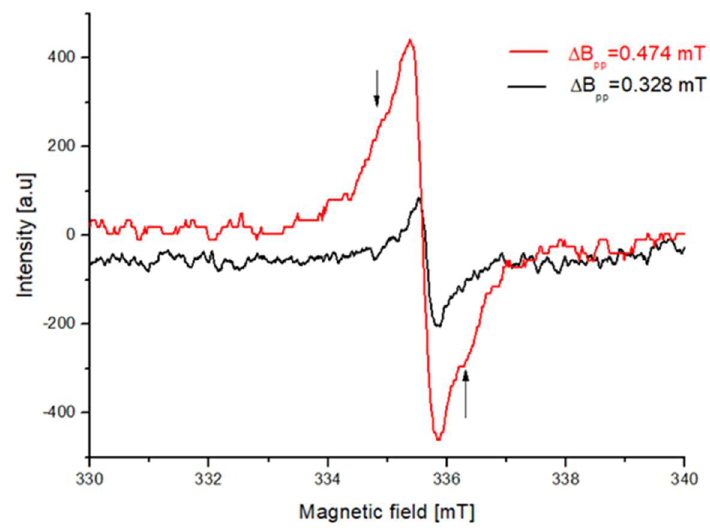
Figure 2. Typical EPR spectrum of the samples after UGmax application from samples D and E (red), and typical spectrum of other samples (black). The arrows indicate double character of EPR spectrum. Intense EPR line (red line) is double line i.e. consists of two signals: a strong narrower signal and a weaker wider signal (marked by arrows).